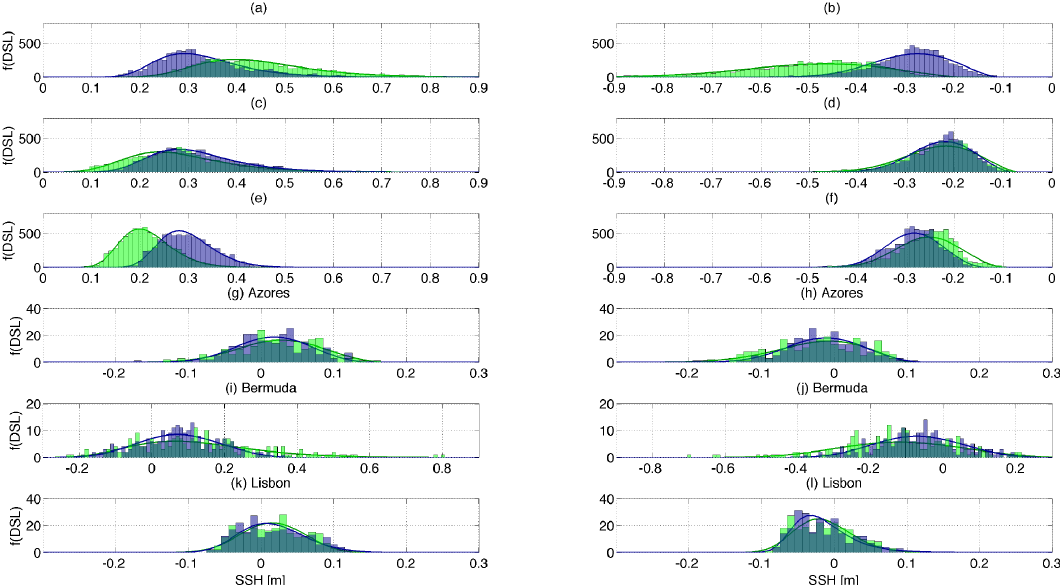
Figure 8. (a, c, e) Estimated probability density function (PDF) of daily regional maximum DSL of simulation R 021 and (b, d, f) of the daily regional minimum DSL in the three different regions in the North Atlantic shown in Fig. 7 ( a region of the subpolar gyre, b near the US east coast, and c near the European coast). In each plot, a maximum daily value over the region is identified after all variability with frequencies lower than 550 days has been filtered out. (g–l) Same but for the locations indicated in Fig. 7 and using (g, i, k) monthly maximum local DSL values and (h, j, l) monthly minimum local DSL values derived from daily mean time series. The green histogram is the PDF for the first 20 years (2001–2020) and the blue histogram that for the last 20 years (2081–2100). The green and blue lines are the GEV distribution function fitted to the corresponding green and blue histogram,